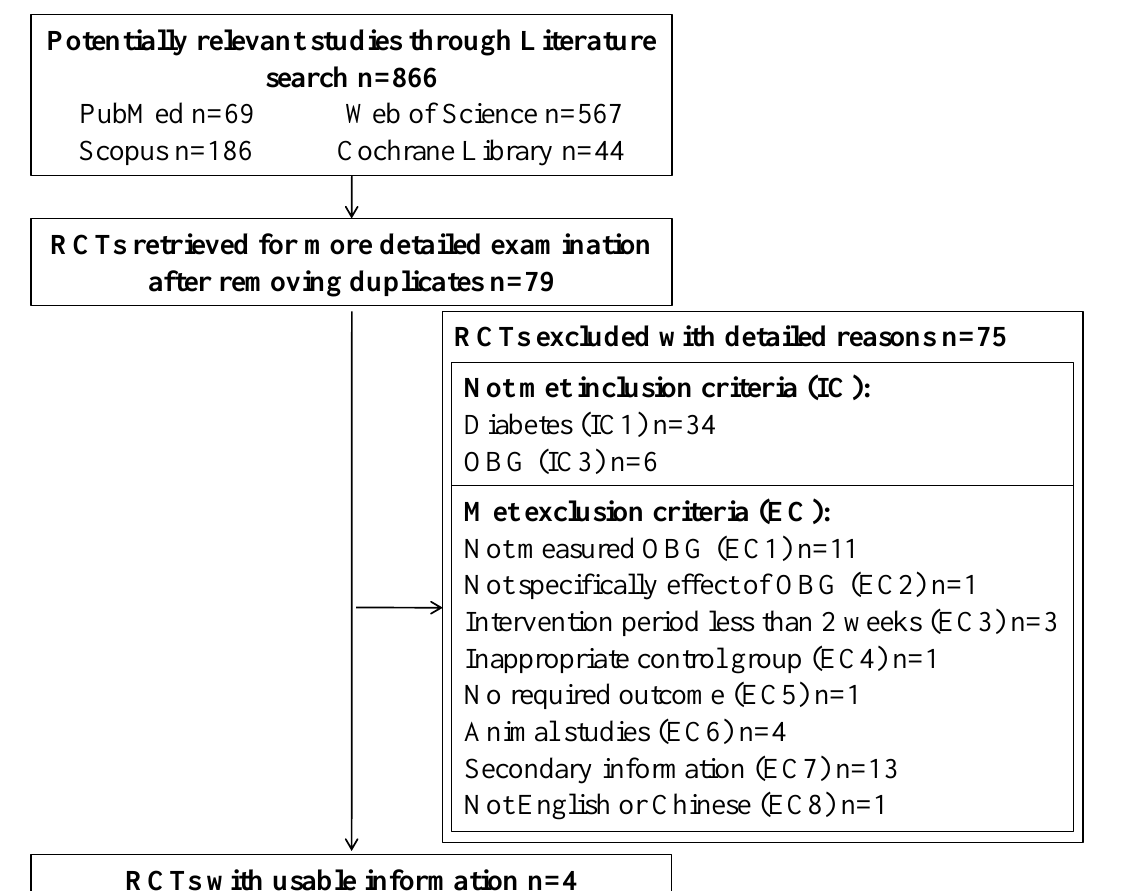
Figure 1. Flow diagram for the selection of randomized controlled trials (RCTs) for the meta-analysis. IC1: RCTs conducted in diabetic patients with either a cross-over or parallel design. IC3: use of oat as